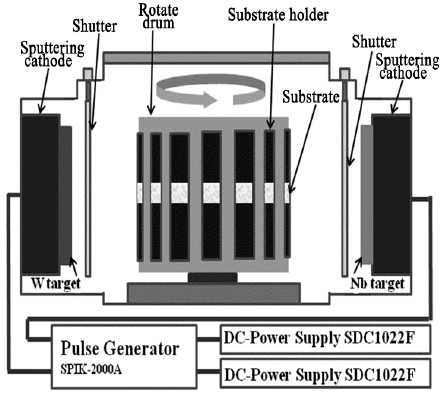
Figure 1. Schematic representation of the fast-alternating asymmetric bipolar pulsed reactive dual magnetron sputtering deposition system. Table 1. Process parameters (pressure, P ; argon flux, f Ar ; oxygen flux, f O ₂ ; sputtering power, P sp ;